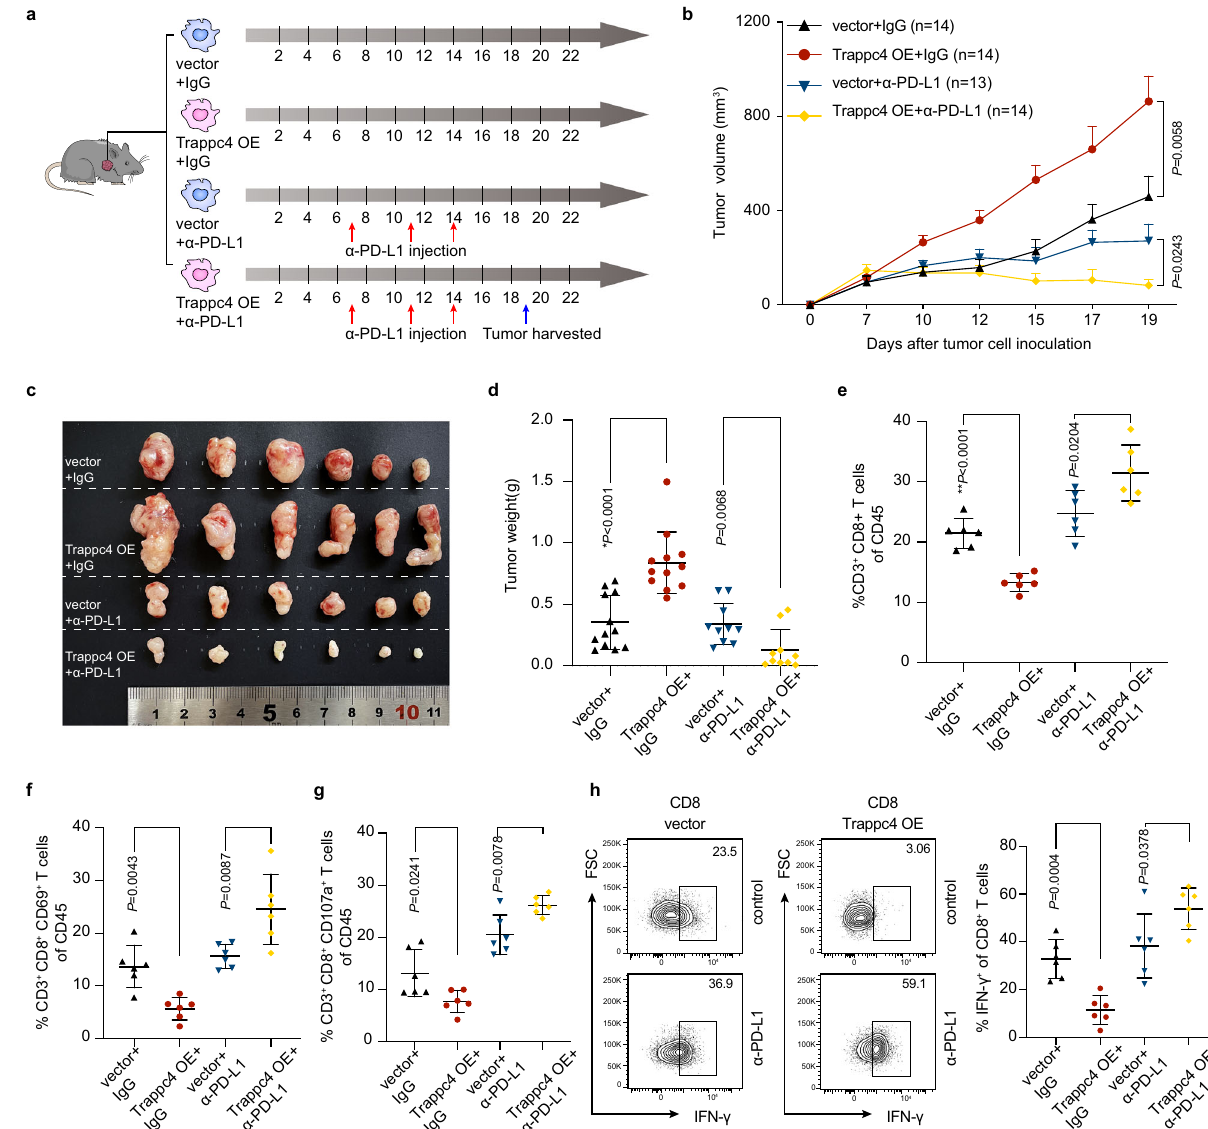
Fig. 6 Overexpression of Trappc4 affects tumor microenvironment composition and immunotherapy ef fi cacy. a Schematic representation of the xenograft mouse model and dosage regimen. Mice bearing control or Trappc4-OE MC38 tumors were treated with anti-PD-L1 mAb. b – d Statistical analysis of tumor volumes ( b ) (vector + α -PD-L1, n = 13; all other groups n = 14), representative images of tumors ( c ) and tumor weights ( d ) (vector + IgG, n = 12, Trappc4-OE + IgG, n = 12, Vector + α -PD-L1, n = 10, Trappc4-OE + α -PD-L1, n = 10) of the mice with subcutaneous tumors in different groups. Values indicate means ±SEM in ( b ) and means ±SD in ( d ), compared by nonparametric Mann – Whitney test, two-sided. ( * P = 7.2e-5) e – h The percentages of CD8 + T cells ( e ), CD69 + CD8 + T cells ( f ), CD107a + CD8 + T cells of CD45 + cells ( g ) and IFN- γ + cells of CD8 + T cells ( h ) in each group ( n = 6 per group) were analyzed by fl ow cytometry. The statistics were plotted as means ±SD, compared by two-sided Student ’ s t test in e , g , h , and nonparametric Mann – Whitney test in f . OE, overexpression. ( ** P = 3.6e-5). Source data are provided as a Source Data fi 1 h at room temperature. Speci fi c bands were developed using an ECL Kit (32106, further analysis. The sequences of siRNAs used for transfection are shown in Thermo Fisher). Immunoreactive protein bands on the western blots were quan- Supplementary Table 4. ti fi ed using the ImageJ software. Immunoprecipitation (IP) was performed as described previously 11 . After Western blotting and immunoprecipitation . Western blotting analysis was per- formed using standard techniques. Cells were collected and lysed using radio- immunoprecipitation assay (RIPA) buffer supplemented with a protease inhibitor cocktail. A bicinchoninic acid (BCA) protein assay kit (Thermo Fisher) was used to determine the concentration of the protein in the samples. Protein samples (25 – 30µg) were separated using 10% sodium dodecyl sulfate-polyacrylamide gel electrophoresis (SDS – PAGE) before being transferred to a polyvinylidene fl uoride membrane (Bio-Rad, Hercules, CA, USA). The membrane was blocked with 5% fat-free milk in Tris-buffered saline buffer for 1h at room temperature and then incubated with the respective primary antibodies overnight at 4°C. Horseradish peroxidase-conjugated secondary antibodies (1: 5000 dilution) were incubated for